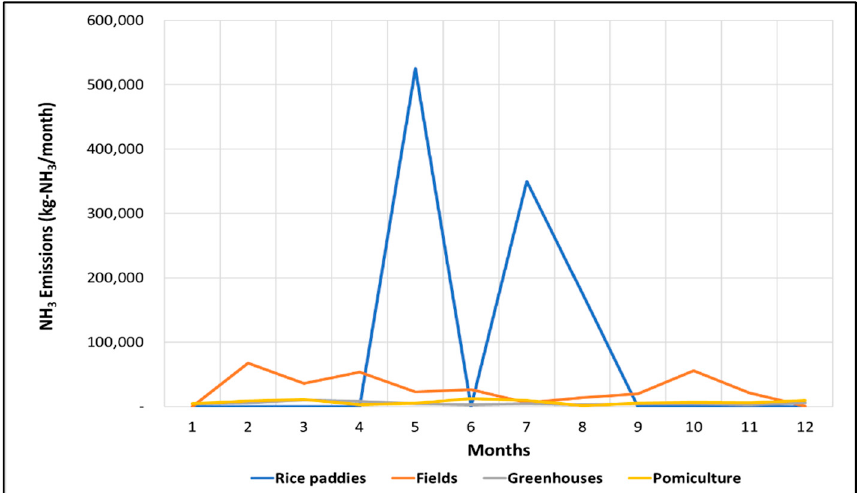
Figure 6. NH 3 emissions by farmland in Jeolla-do (2017) with Method